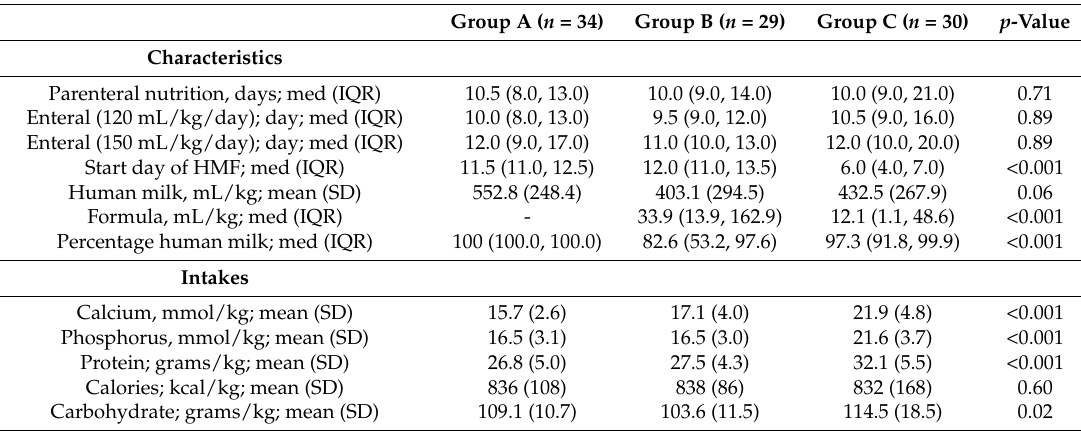
Table 2. Nutritional characteristics during the first 10 days of life.